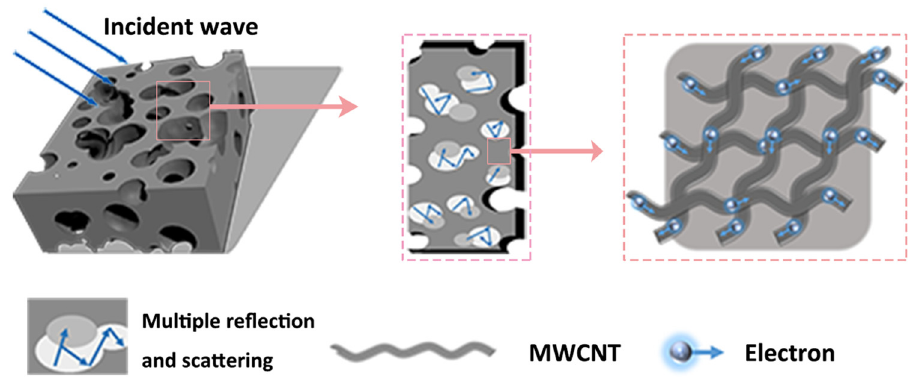
Figure 6: Schematic illustration of electromagnetic shielding mechanisms for foam composite.